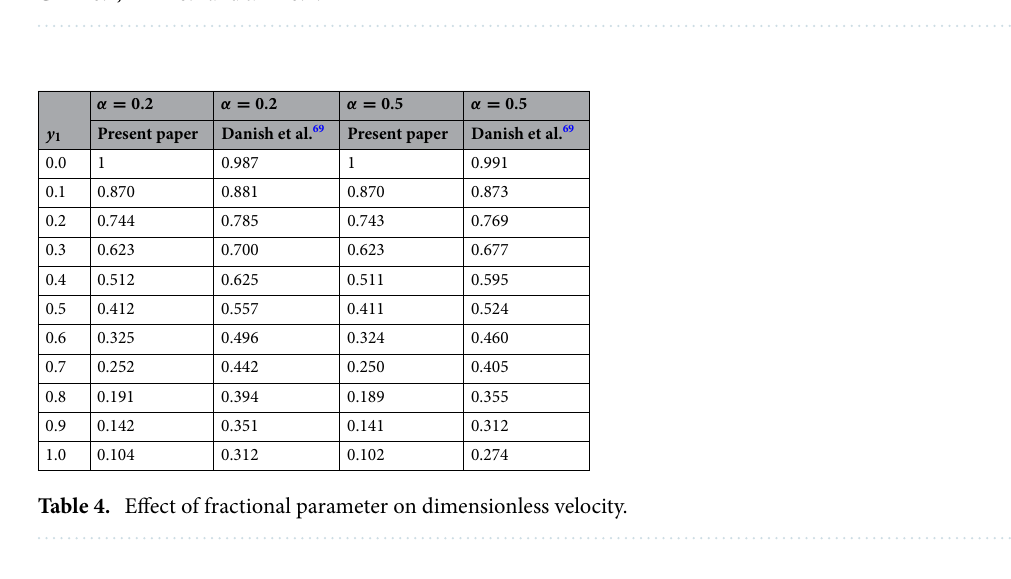
Figure 9. Comparison of velocity profile with Danish et al. 69 , when: t = 0.02 , φ = 0.04 , Pr = 6.2 , (cid:31) = 0.001 , Gr = 0.1 , M = 0.1 and α = 0.2.